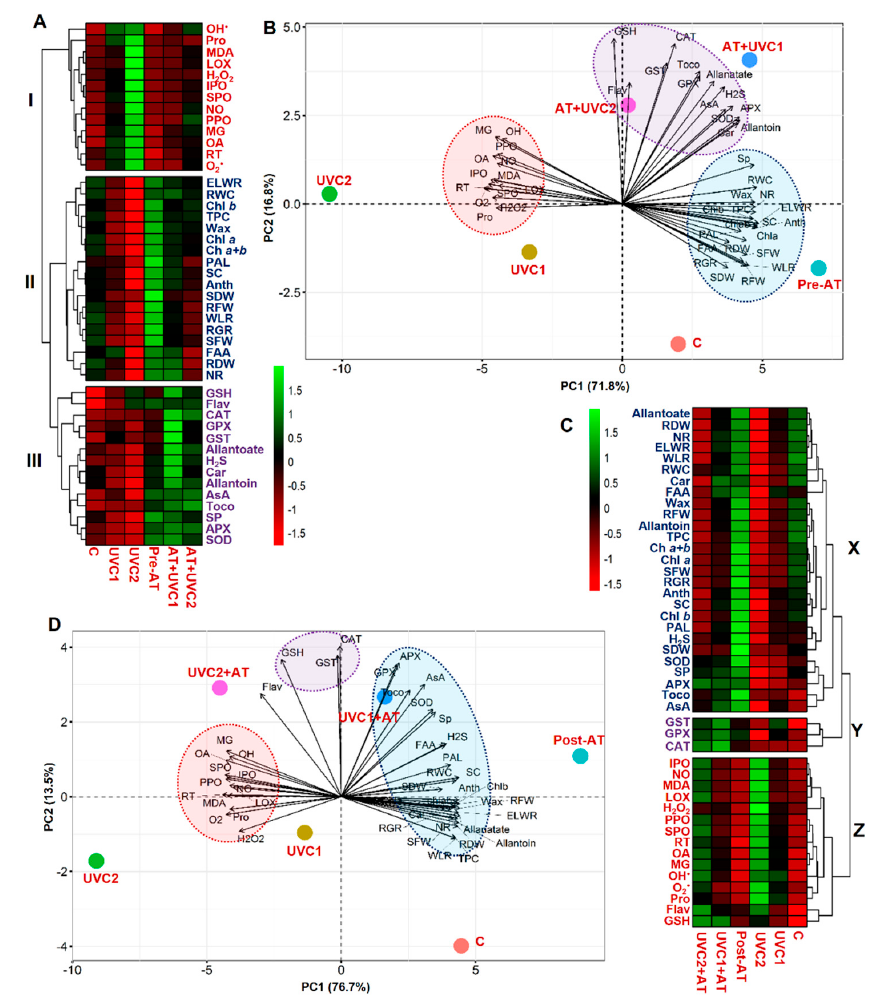
Figure 6. Hierarchical clustering with heatmap ( A , C ) and principal component analysis (PCA) ( B , D ) show the treatment-variable relationships. In hierarchical clustering and heatmap, the mean values of various parameters obtained in this study were normalized and analyzed. Three distinct clus- ters (cluster I–III for pre-treatment ( A ) and cluster X-Z for post-treatment ( C )) were identified at the variable level. In the heatmap, the color scale displays the intensity of normalized mean values of different parameters. The entire dataset was also divided to analyze PCA of AT pre-treatment ( B ) and post-treatment ( D ). The variables included RGR, relative growth rate; SFW, shoot fresh weight; RFW, root fresh weight; SDW, shoot dry weight; RDW, root dry weight; WLR, water loss rate; ELWR, excised leaf water retention; RT, residual transpiration; Chl, chlorophyll; Car, carotenoid; RWC, relative water content; Wax, epicuticular wax; Pro, proline content; FAA, free amino acid content, SP, soluble protein content; SC, soluble carbohydrate content; O 2 •− , superoxide content; • OH, hydroxyl radical content; H 2 O 2 , hydrogen peroxide content; MDA, malondialdehyde content; LOX, lipoxygenase activity; MG, methylglyoxal content; GSH, glutathione content; AsA; ascor- bic acid content; Anth, anthocyanin content; Flav, flavonoid content; Toco, α -tocopherol content;